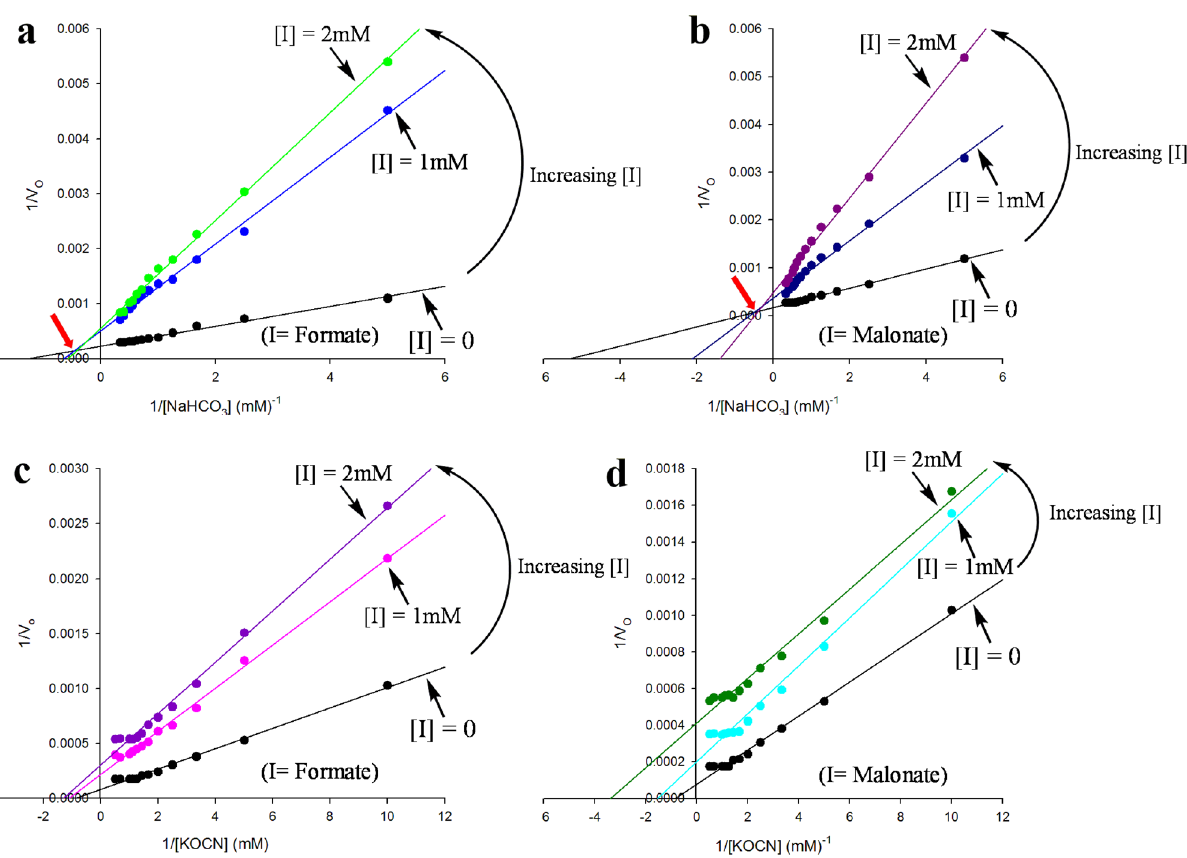
Figure 4. Kinetic studies on the inhibition of Tl-Cyn by malonate and formate. ( a , b) A set of double-reciprocal plots, one obtained in the absence of inhibitor and two at different concentrations of inhibitor, formate and malonate, respectively in the presence of varying concentrations of NaHCO 3 . The location of the intersection point of the lines is indicated with the red arrow. ( c , d) A set of double-reciprocal plots, one obtained in the absence of inhibitor and two at different concentrations of inhibitor, formate and malonate, respectively in the presence of varying concentrations of KOCN. Data points are means taken from three representative set of